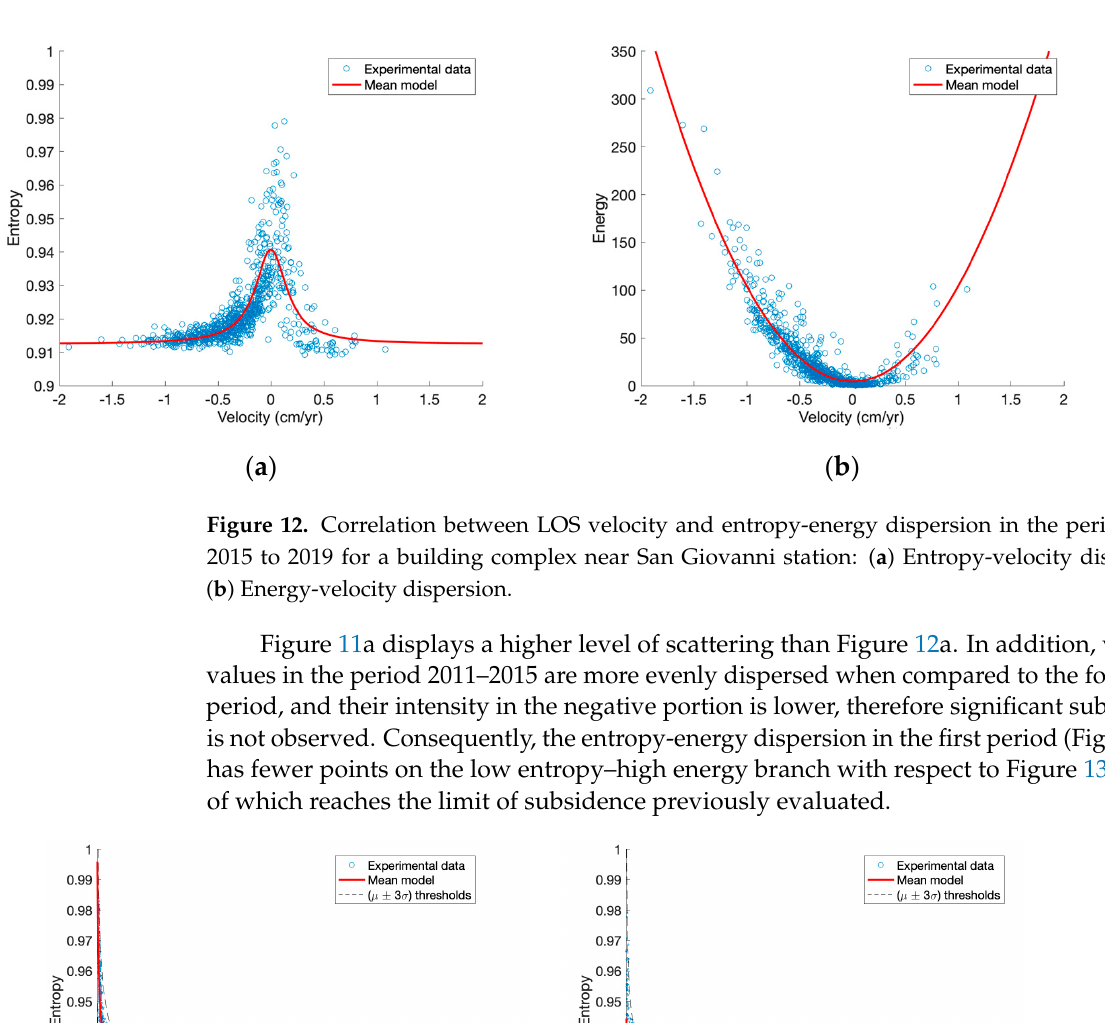
Figure 11. Correlation between LOS velocity and entropy–energy dispersion in the period from 2011 to 2015 for a building complex near San Giovanni station: ( a ) Entropy–velocity dispersion; ( b ) En- ergy–velocity dispersion.